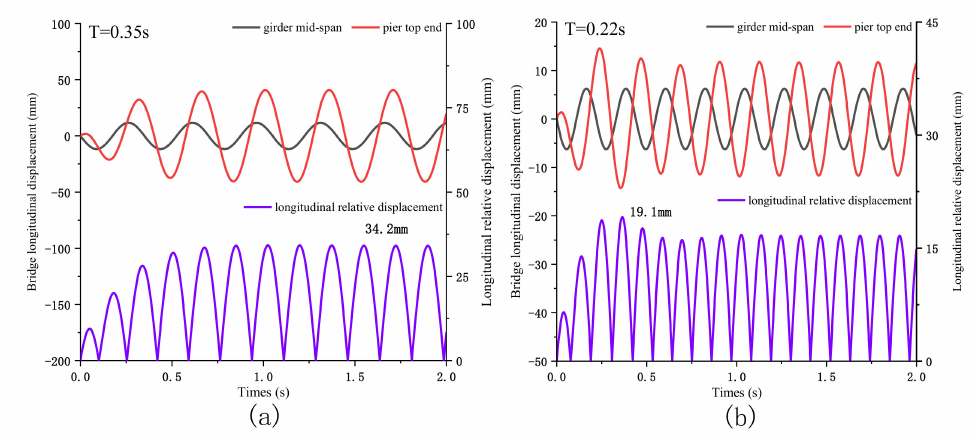
Figure 4. Bridge longitudinal displacement response: ( a ) T = 0.35 s; ( b ) T = 0.22